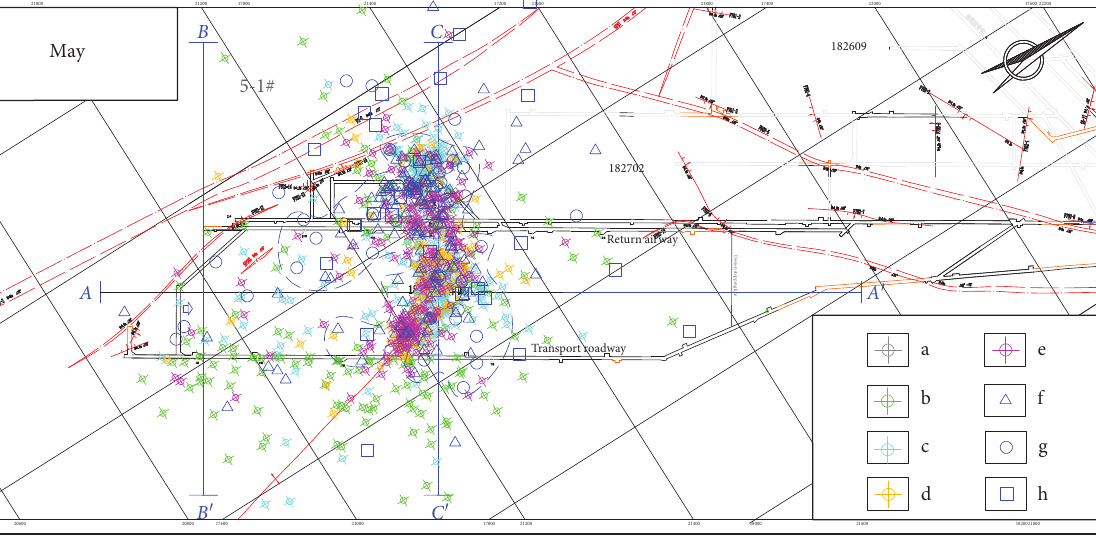
Figure 12: Distribution plan of microseismic events in May. a: shallow of 2# coal; b: floor of 2# coal--floor of Yeqing limestone; c: floor of Yeqing limestone-floor of Fuqing limestone; d: floor of Fuqing limestone-floor of Daqing limestone; e: floor of Danqing limestone-roof of Ordovician limestone; f: Ordovician limestone (0–50m); g: Ordovician limestone (51–150m); h: Ordovician limestone (150m-deep